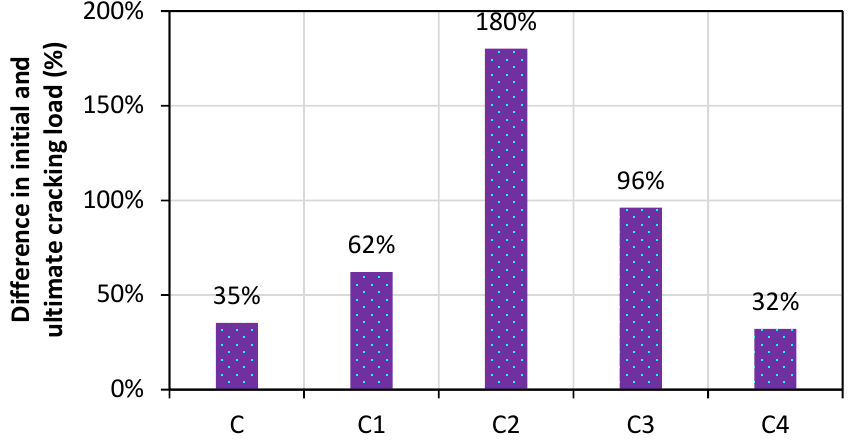
Figure 36. Difference in percentage between the initial and final cracking load of the specimens.